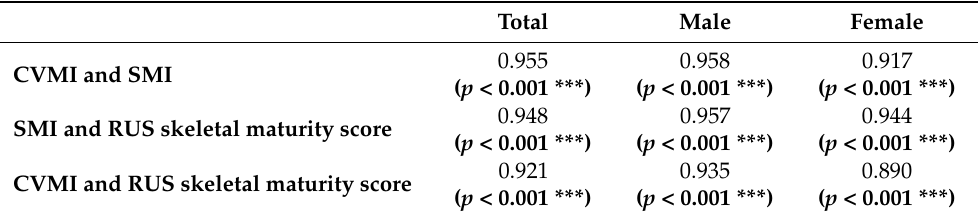
Total Male Female 0.955